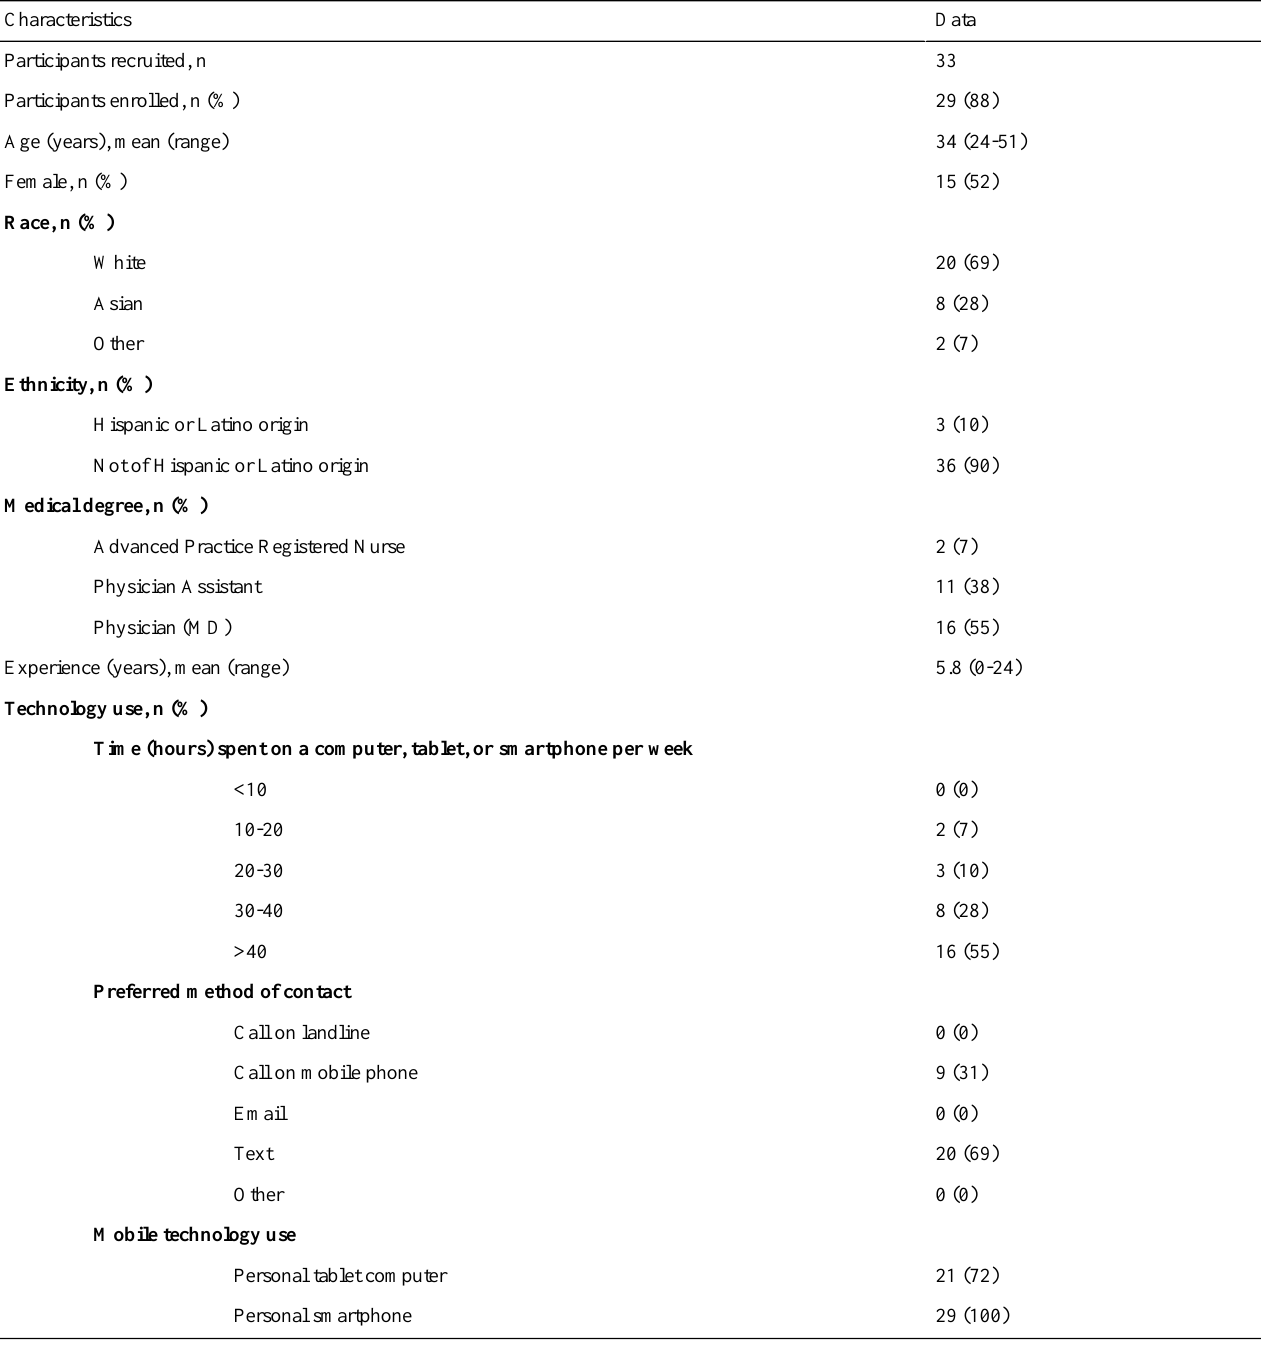
Table 2. Clinician